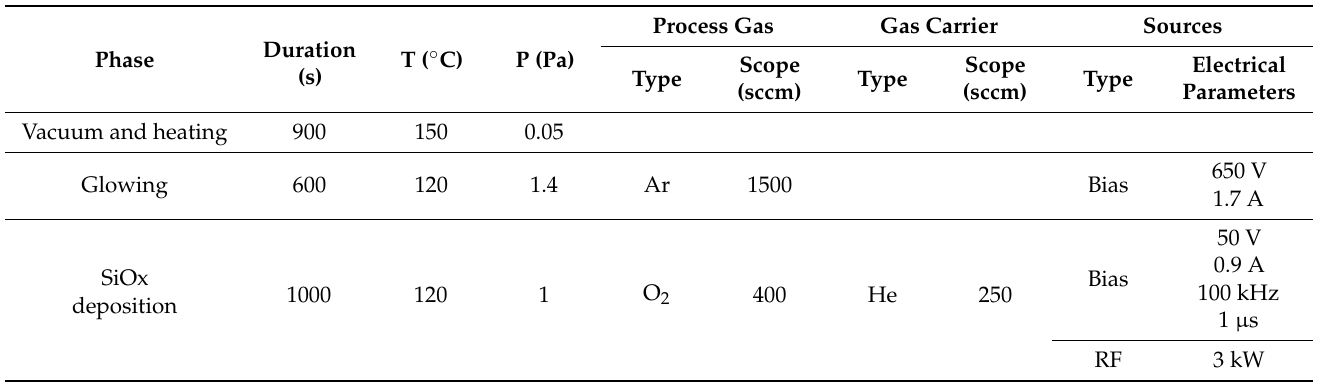
Table 2. Summary of PE-CVD deposition parameters employed for coating of Surf 4 samples (SiO x 30 g/h, 400 sccm, O 2 RF 3